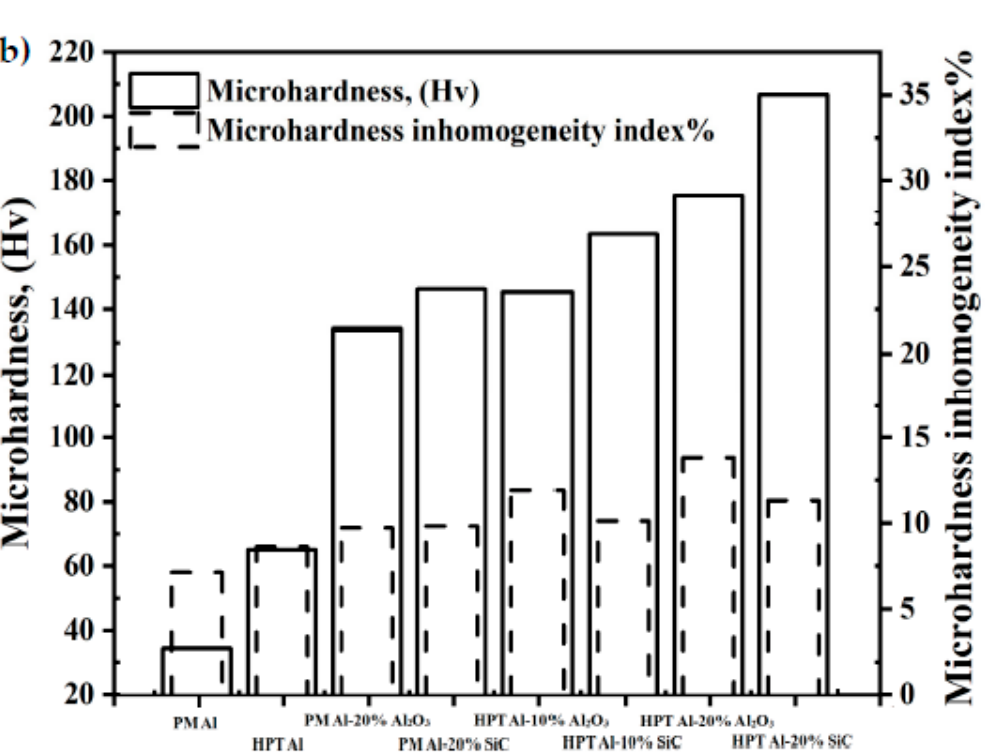
Figure 8. ( a ) Microhardness distribution across the diameter of the samples and ( b ) average micro- hardness and microhardness inhomogeneity index of the different samples.